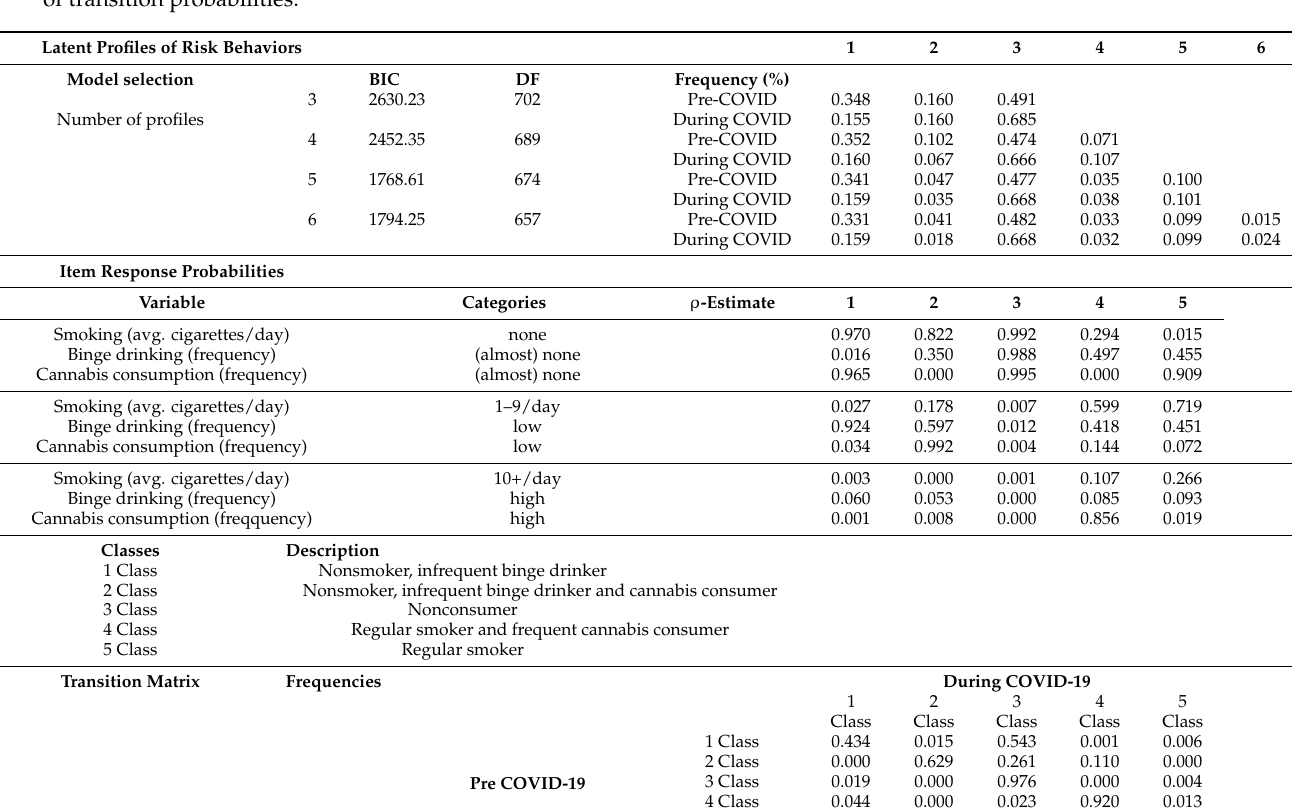
Table 6. Latent profile analysis of three HRBs (Smoking, binge drinking and cannabis consumption). Model selection and fit statistics (Bayesian information criterion), item-response probabilities ( ρ -estimate), latent class characterization and matrix of transition